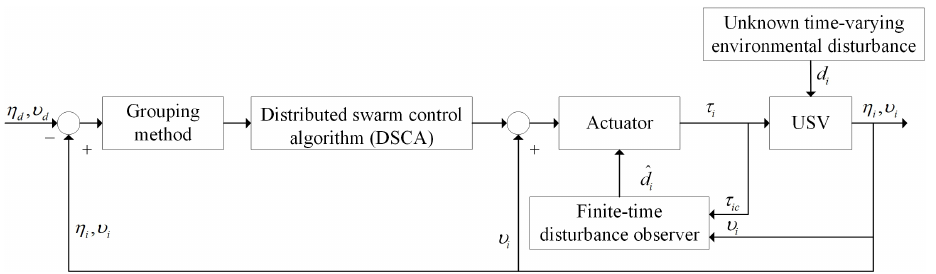
Figure 7. The diagram of the proposed grouping method, distributed swarm control algorithm and other control technology for multiple